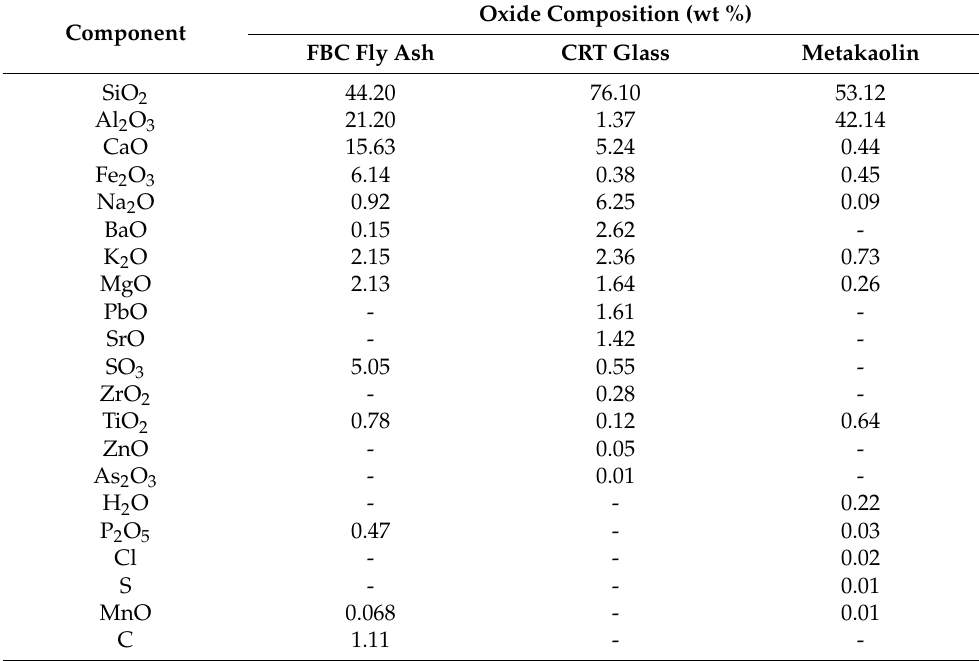
The mixture of commercial sodium silicate solution and sodium hydroxide was used as an activator in all mixtures. The producer provided the following characterization of sodium silicate solution: ratio of SiO 2 to Na 2 O between 2.4 and 2.6. The minimum content of oxides (SiO 2 and Na 2 O) equals 39%. Sodium hydroxide solution was prepared